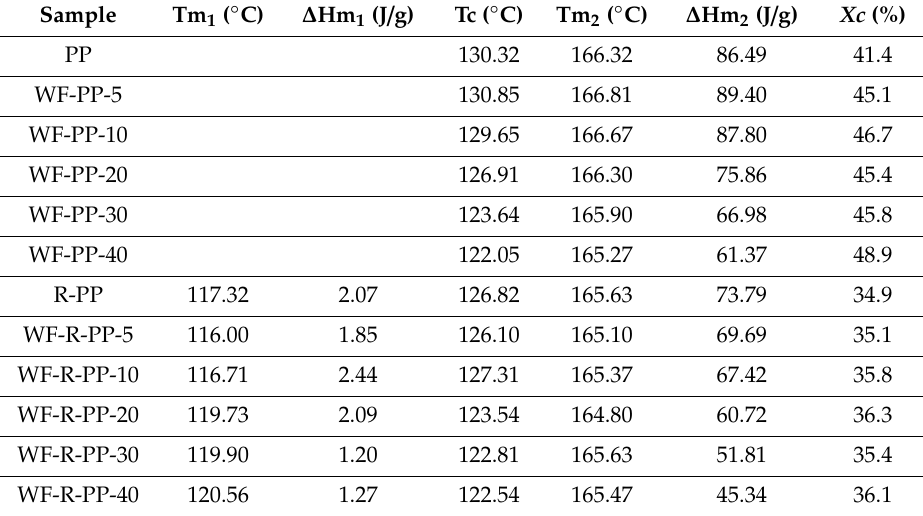
Table 4. Thermal parameters of the investigated